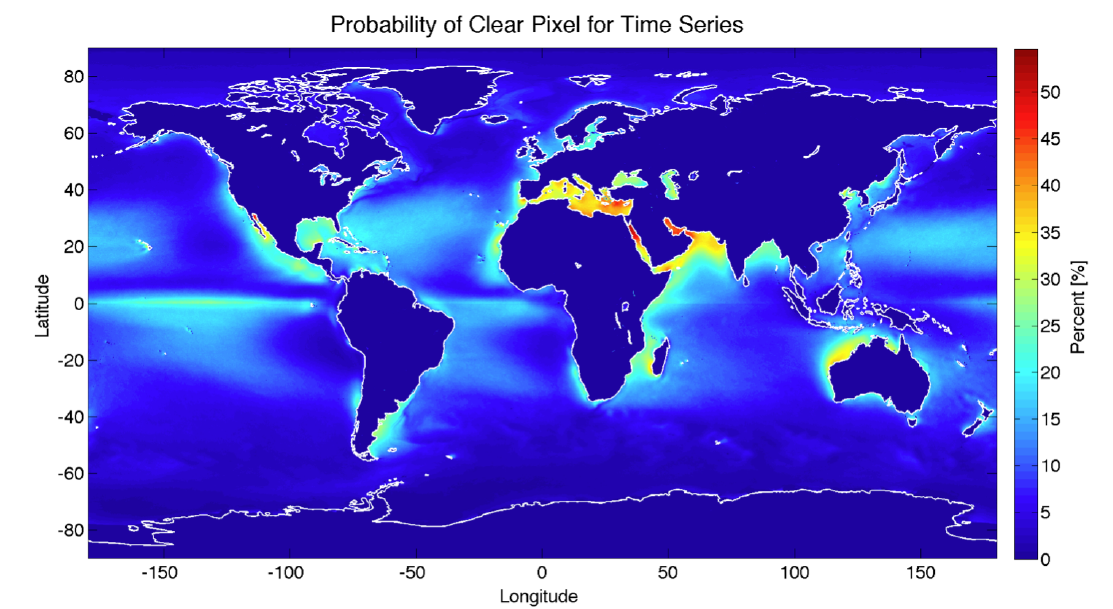
Figure A1. Probability of clear pixel for the time series (1982–2011) considered in the climatology of the maximum gradient of SST from University of Rhode Island (URI) Pathfinder 9 km frontal database (courtesy of Peter Cornillon Graduate School of Oceanography, University of Rhode Island